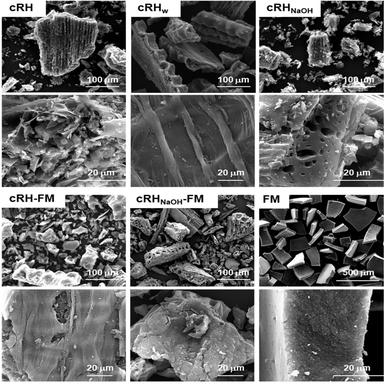
SEM images of the materials at different magnifications.